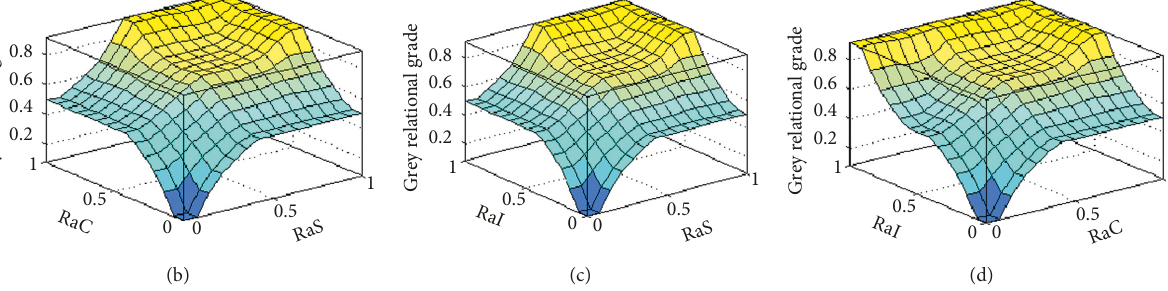
Figure 10: Influence of output responses on